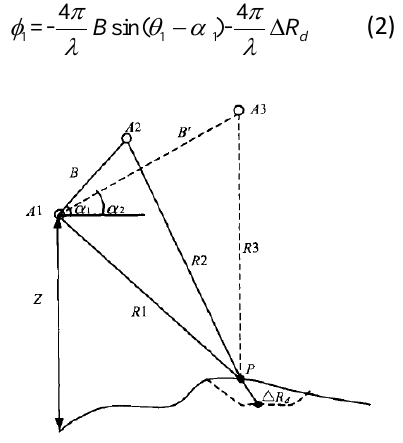
Figure 2. Figure of "Three-track" method It is necessary to eliminate the terrain information of the area before get the deformation information of the surface, we then use the third SAR image to eliminate the impact of terrain by interference methods. It is known as the "three-track